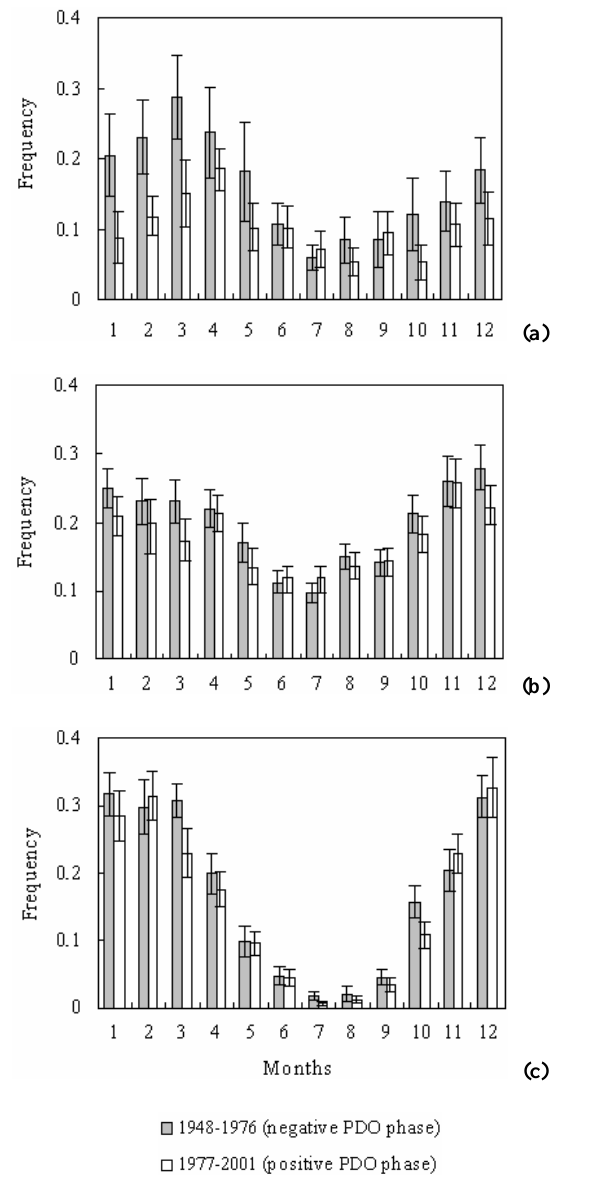
Figure 5. Composite values of the frequency of cyclones in the (a) Black Sea region, (b) Western Mediterranean and (c) East- ern Mediterranean during the negative (1948–1976) and positive (1977–2001) PDO phase. Confidence level corresponds to the 80% of statistical